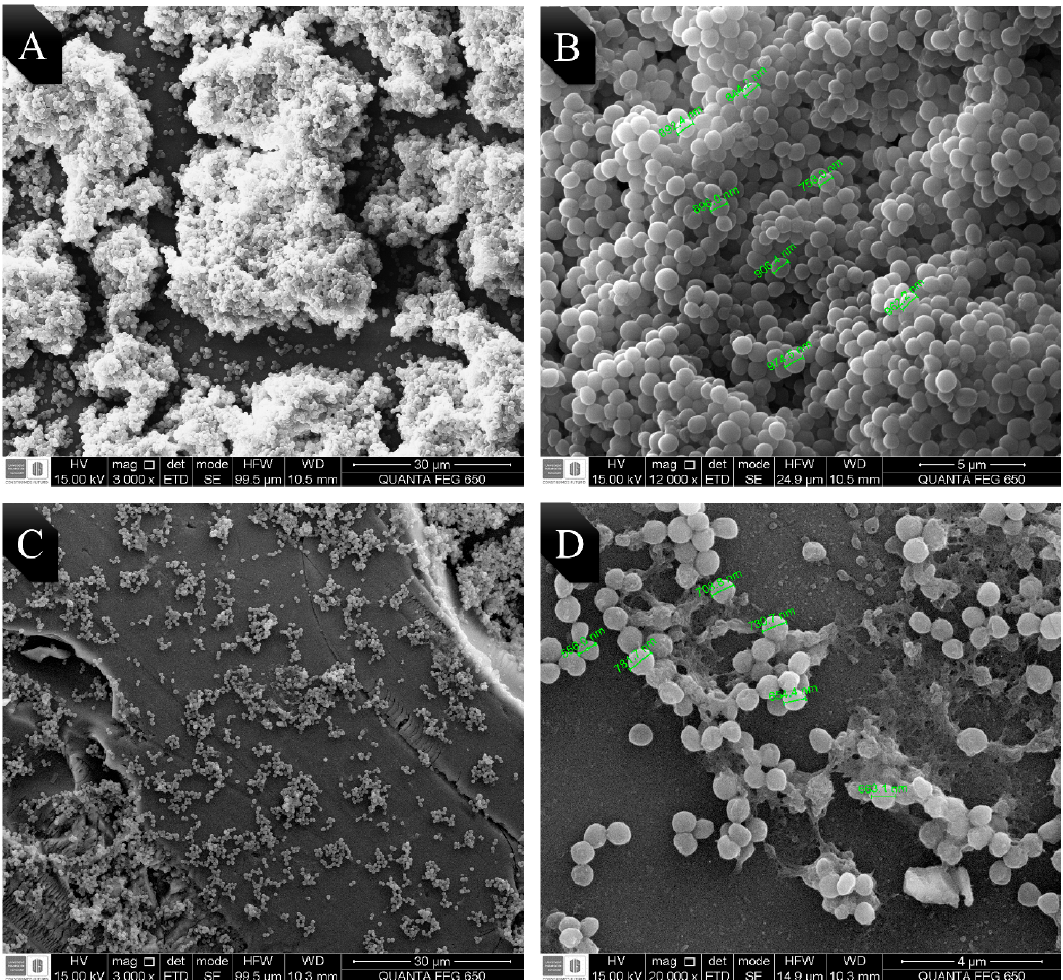
Figure 2. Micrographs of MRSA on frosted glass coupons obtained by SEM. ( A ) Biofilm control of MRSA at 3000×. ( B ) Magnification of the biofilm control at 12,000×. ( C ) MRSA biofilm treated with LOC (0.5 MIC50) at 3000×. ( D ) Magnification of the MRSA biofilm treated with LOC (0.5 MIC50) at 20,000×.